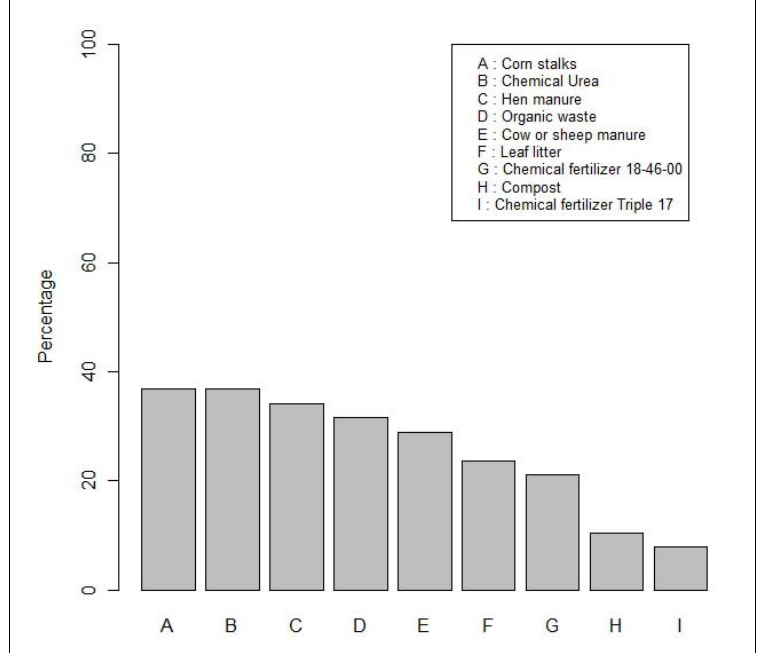
Figure 8. Fertilization Used by San Cristobal Growers From Survey of Farmers in Areas Surrounding San Cristobal